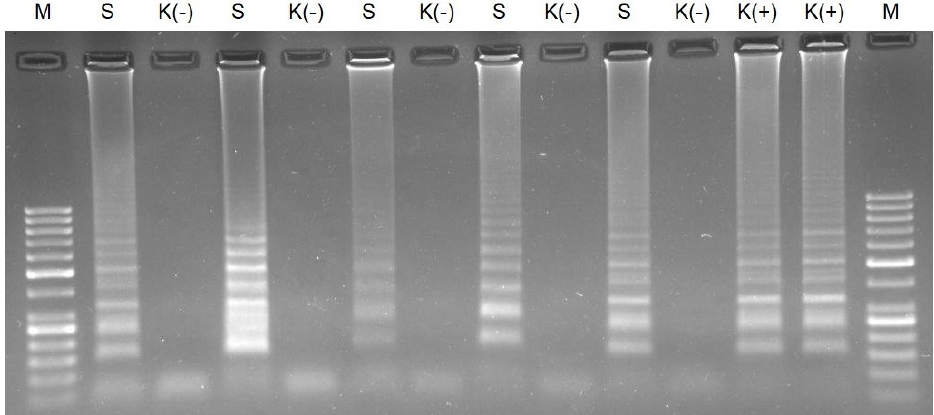
Figure 6. Agarose gel electrophoresis of RT-LAMP for clinical samples conducted for 40 min. M— molecular DNA marker 100 bp; S—clinical sample; K ( ‐ )—negative control; and K (+)—AMPLIRUN SARS ‐ CoV ‐ 2 RNA control at concentration 3000 copies/reactions.